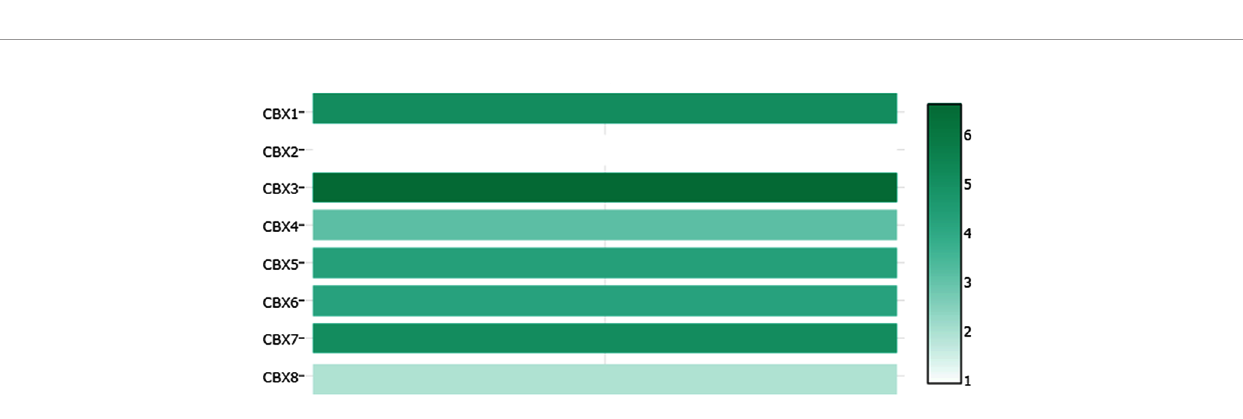
FIGURE 5 | The protein expression levels of CBX3, CBX6 and CBX7 in ccRCC tissues and paired adjacent normal kidney tissues (Immunohistochemistry). CBX3 was overexpressed in ccRCC tissues compared to normal kidney tissues, while expression levels of CBX6 and CBX7 were reduced in ccRCC tissues. The representative immunohistochemistry image of CBX3, CBX6 and CBX7 in ccRCC tissues and normal kidney tissues (A, C, E) . The scatter plot of immunohistochemistry score (B, D, F) . (* P <0.05, ** P <0.01, *** P <0.001).